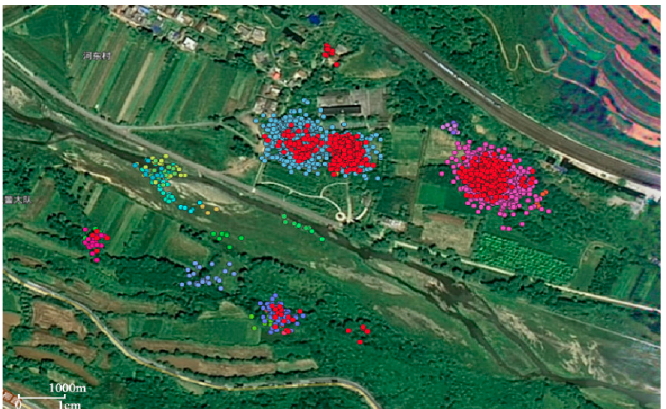
Figure 4. Identification results of crested ibis’s habitats based on spatial and temporal density. Track data points of all the tagged crested ibis in colors other than red represent different types of stops. The overlapping areas of red stopping points and other color stopping points indicate crested ibis’ overnight sites. Only the red stop point area indicates the occasional nightspot of crested ibis. The stopping areas without red stopping points indicate crested ibis’ foraging sites.